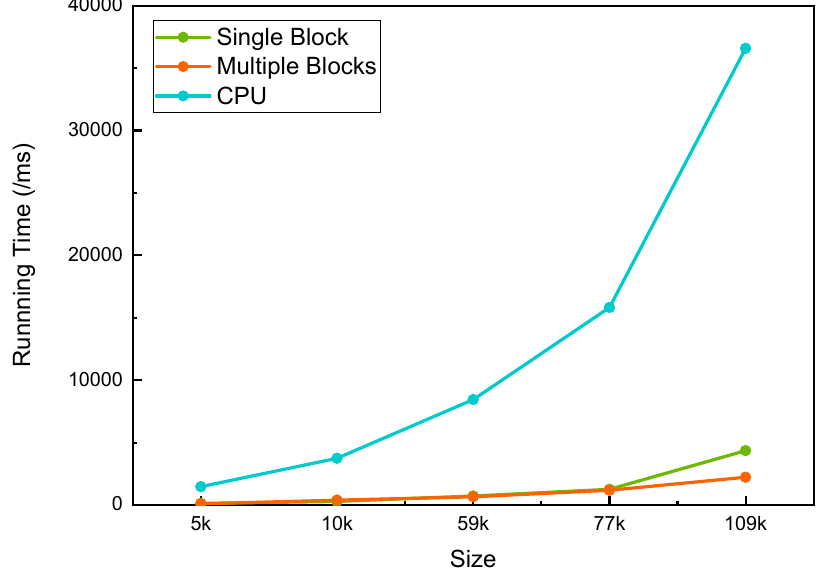
Figure 11. Comparison of the running time in serial and parallel versions.